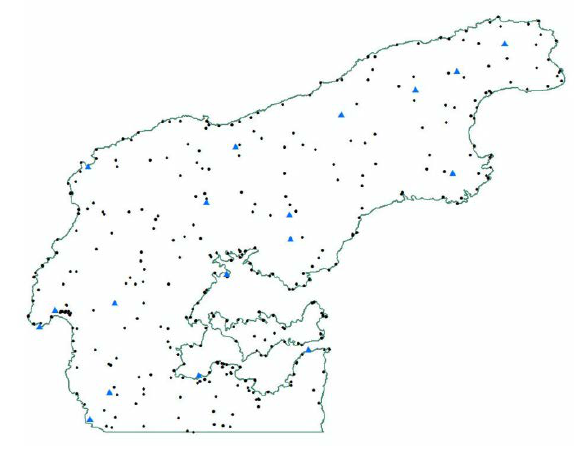
Figure 4. Samples in stratum of points (blue points represent samples).